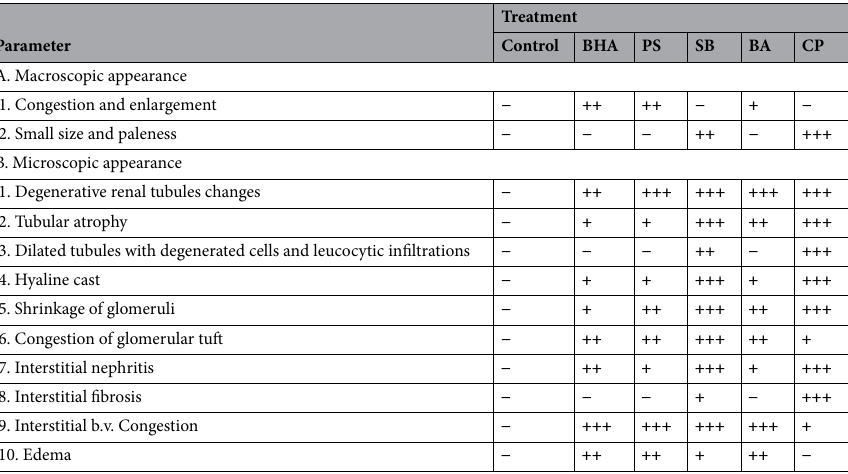
Table 4. The lesion scoring of renal tissues of butylated hydroxyl anisole (BHA), potassium sorbate (PS), sodium benzoate (SB), boric acid (BA), or calcium propionate (CP)-treated rats. Control group: received distilled water. BHA group: 0.09 mg/kg b.wt. PS group: received 4.5 mg/kg b.wt. SB group: received 0.9 mg/kg b.wt. BA group: received 0.16 mg/kg b.wt. CP group: received 0.18 mg/kg b.wt. Rats were orally given all food preservatives for 90 days. −: Absence of lesion; +: Mild; ++: Moderate; +++: Severe damage. N = 10/each group.